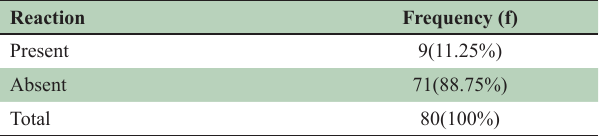
Hypersensitivity reaction among respondents.